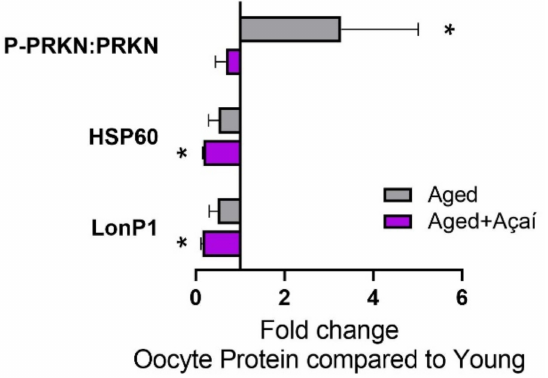
Figure 5. Effects of aging and aça í on oocyte signaling. Protein levels in the oocytes are presented as a fold change compared to young mice (n = 6 mice per group). The data were analyzed by the Kruskal–Wallis test with Dunn’s multiple comparisons when the overall effect p < 0.05. * p < 0.05 compared to young